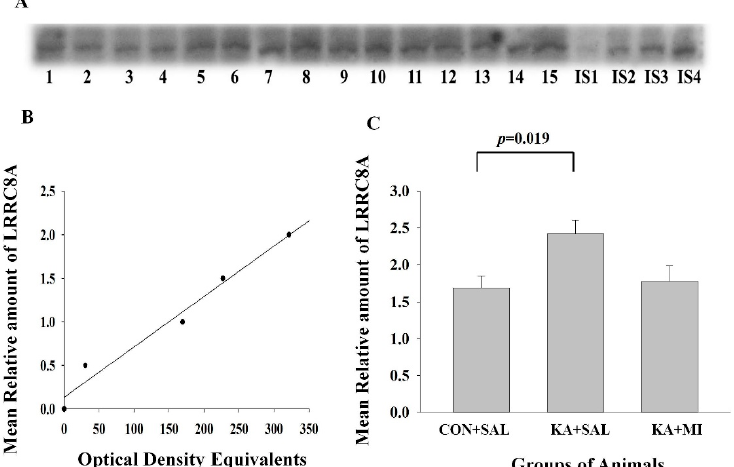
Figure 5. LRRC8A protein is increased in the hippocampus of KA + SAL group. ( A ) Sample film, ( B ) Calibration plot (lines fitted by linear least-squares regression) and ( C ) Mean levels (mean ± sem). Each lane corresponds to one sample. Lanes 1–5 are from CON + SAL group; lanes 6–10 from KA + SAL group and lanes 11–15 from KA + MI group. Lanes IS-1-IS4 internal standards containing, respectively, 15, 30, 45, and 60 µ g protein. The details of statistical analysis are provided in the manuscript.